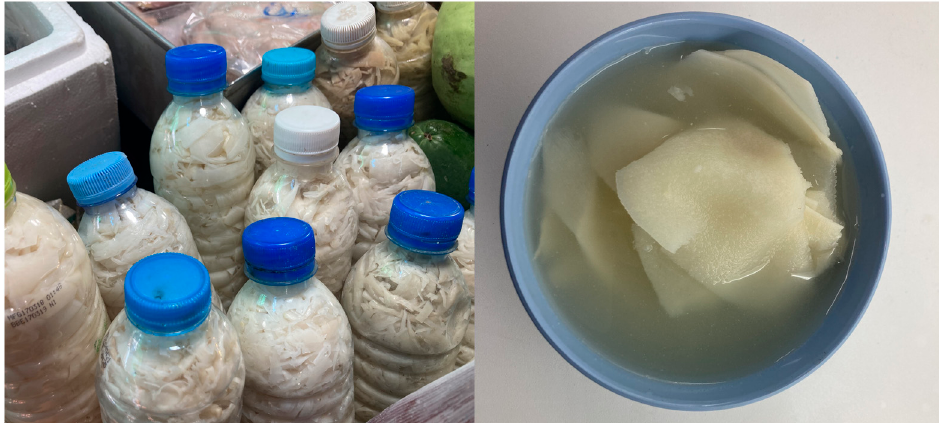
Figure 1. Appearance of Naw Mai Dong commercially available in a local market.